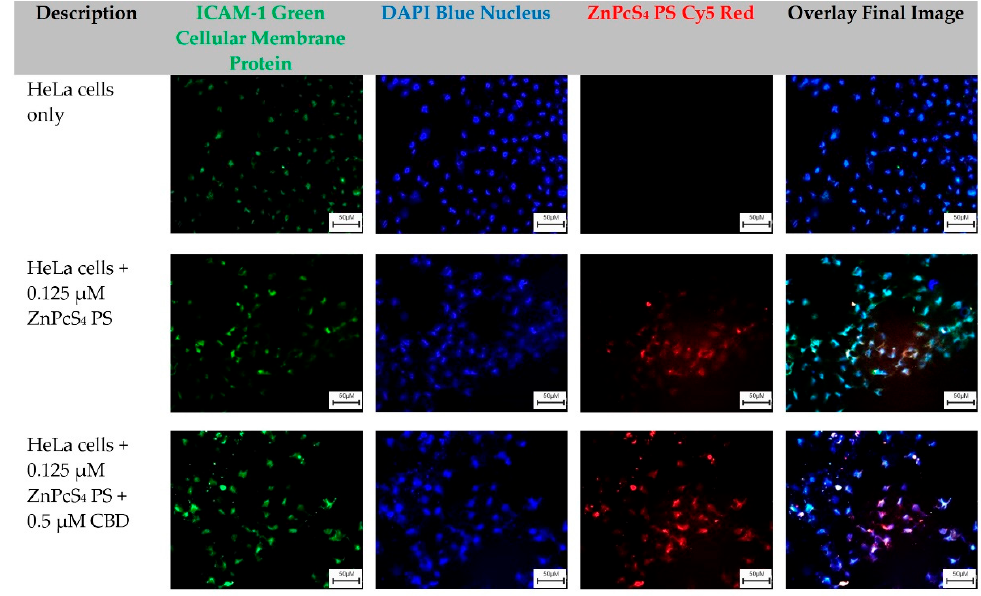
Figure 3. Subcellular localization comparison of various control and experimental groups of HeLa cells treated with singular and combinative ZnPcS 4 PS and/or CBD pre-irradiation; DAPI-stained nuclei (blue), ICAM-1 cellular membrane proteins (green) and Cy5 fluorescence from ZnPcS 4 PS subcellular localization (red) (40× magnification, 50 µM scale bar).